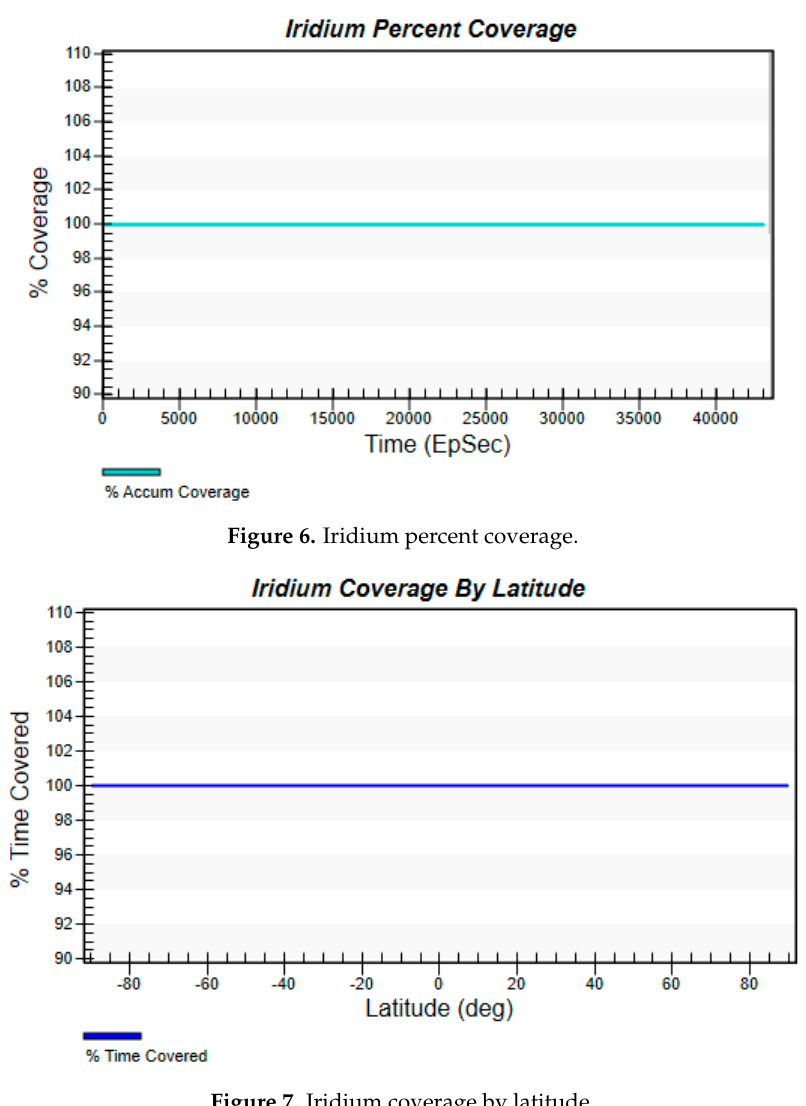
Figure 7. Iridium coverage by latitude.